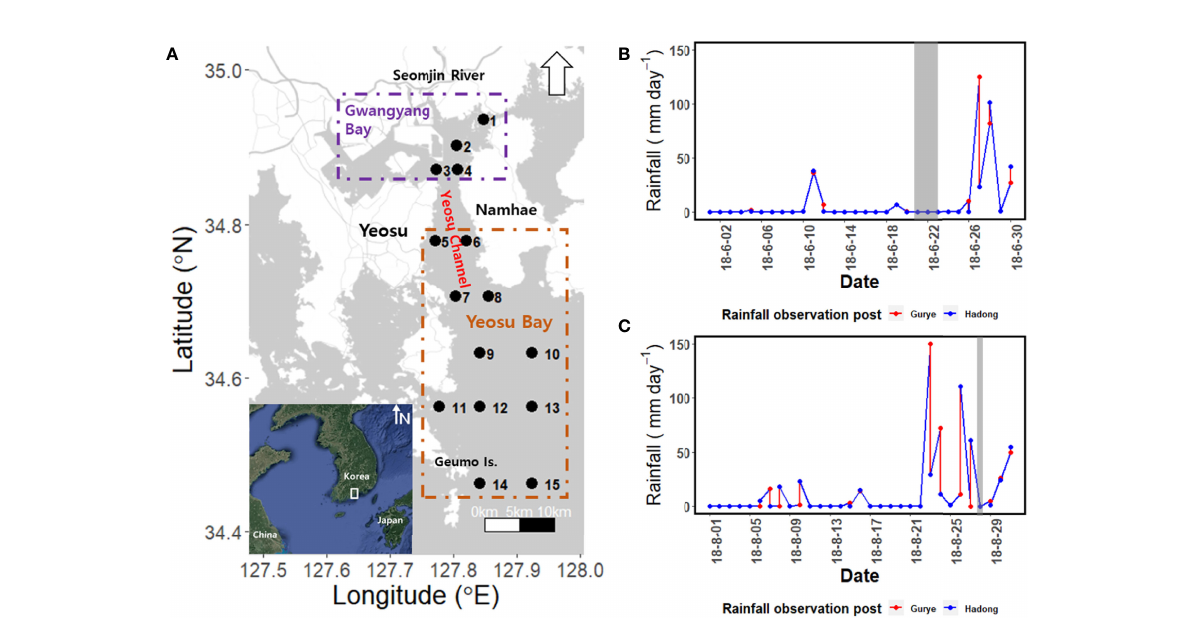
FIGURE 1 (A) Map of the study region, including the Yeosu Channel. Rainfall data for Seomjin River (B) upstream (Gurye) and (C) downstream (Hadong). Shaded dates indicate the survey